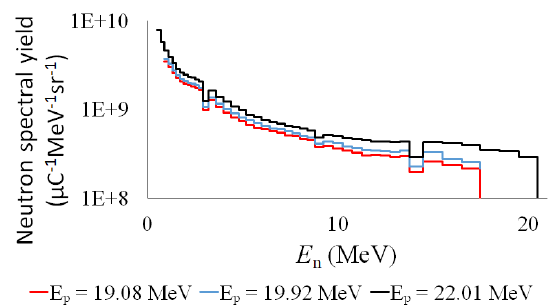
Figure 2. Neutron energy spectra from the source reaction p+Be measured by Brede et al. for proton energies of 19.08 MeV, 19.92 MeV and 22.01 MeV [10,